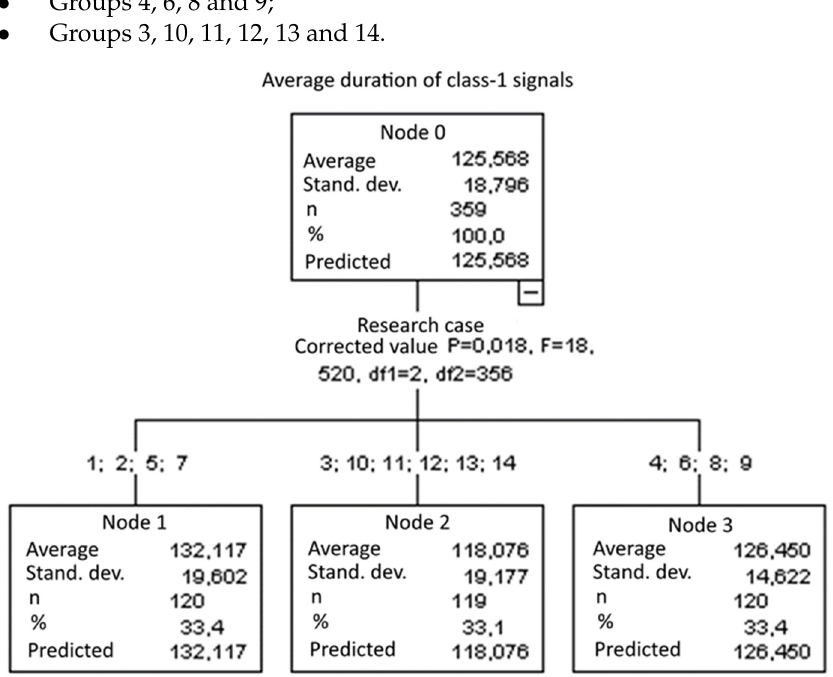
Figure 18. Classification tree for the average duration of class-1 signals.